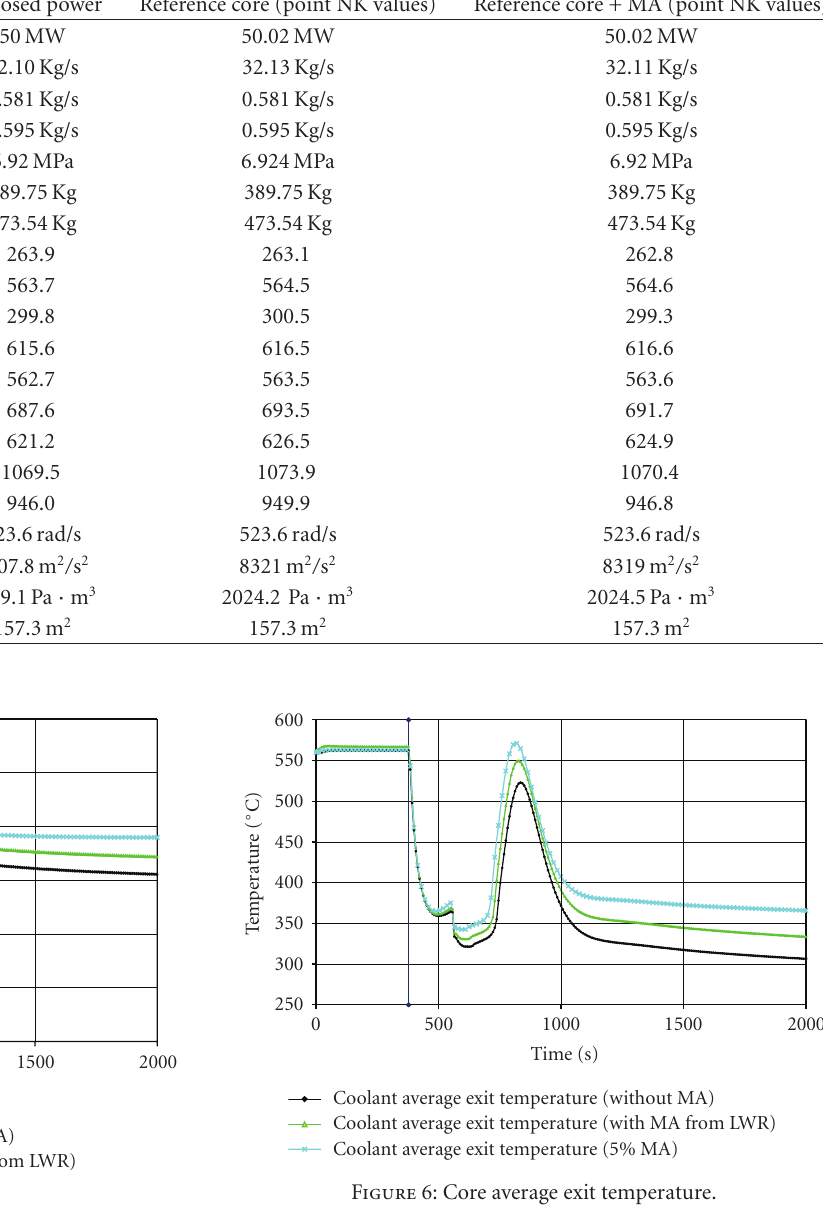
Figure 5: Pressure at the top of the vessel.